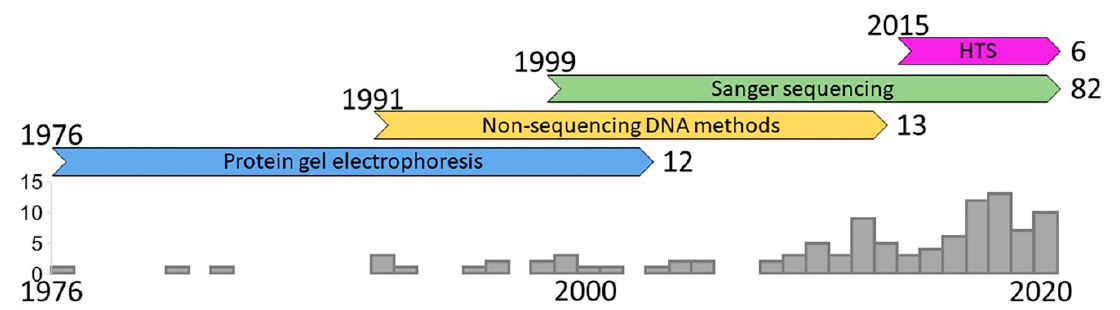
Figure 1. Historical timeline of the development of molecular species delimitation in Clitellata, showing the year of the first study, and the total number of studies, of the four major categories of methods referenced in this paper (see Table S1 for details). The histogram shows the total number of studies (all categories) per year.